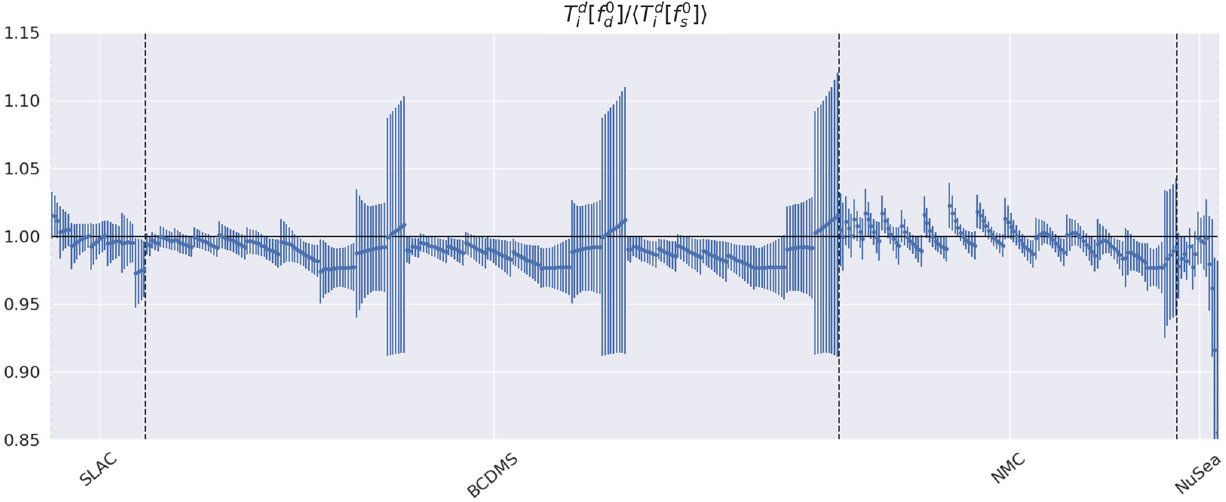
Fig. 2 The ratio between the SLAC, BCDMS, NMC and DYE866/NuSea deuteron observables computed either with the central prediction with deuteron PDFs, T d